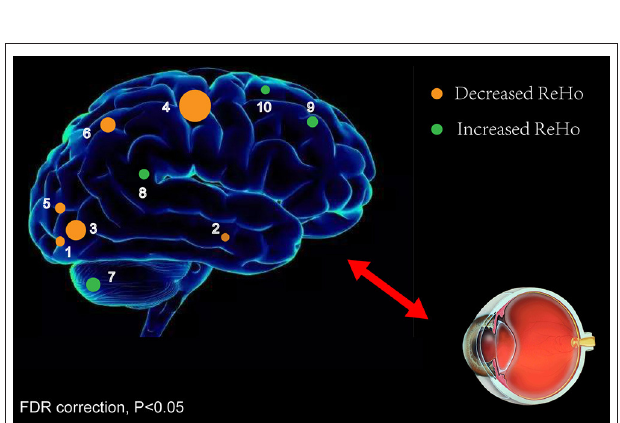
FIGURE 6 | ReHo results of spontaneous neuronal activity in the iridocyclitis group. Compared to the healthy volunteers, the ReHo value of iridocyclitis patients in regions 1–6 was decreased to various extents, while the value of regions 7–10 was increased: [1] right inferior occipital gyrus ( t = − 3.8763), [2] right middle temporal gyrus ( t = − 4.0949), [3] right calcarine ( t = − 5.2475), [3] left calcarine ( t = − 4.2266), [4] right postcentral gyrus ( t = − 7.0129), [5] left superior occipital gyrus ( t = − 4.5975), [6] left precuneus ( t = − 4.5016), [7] right cerebellum ( t = 5.1730), [8] left putamen ( t = 4.9854), [9] left inferior frontal gyrus ( t = 5.3275), and [10] left supplementary motor area ( t = 4.2742). Note: Spot sizes indicate degrees of quantitative changes. Abbreviations: ReHo, regional homogeneity; FDR, false discovery rate